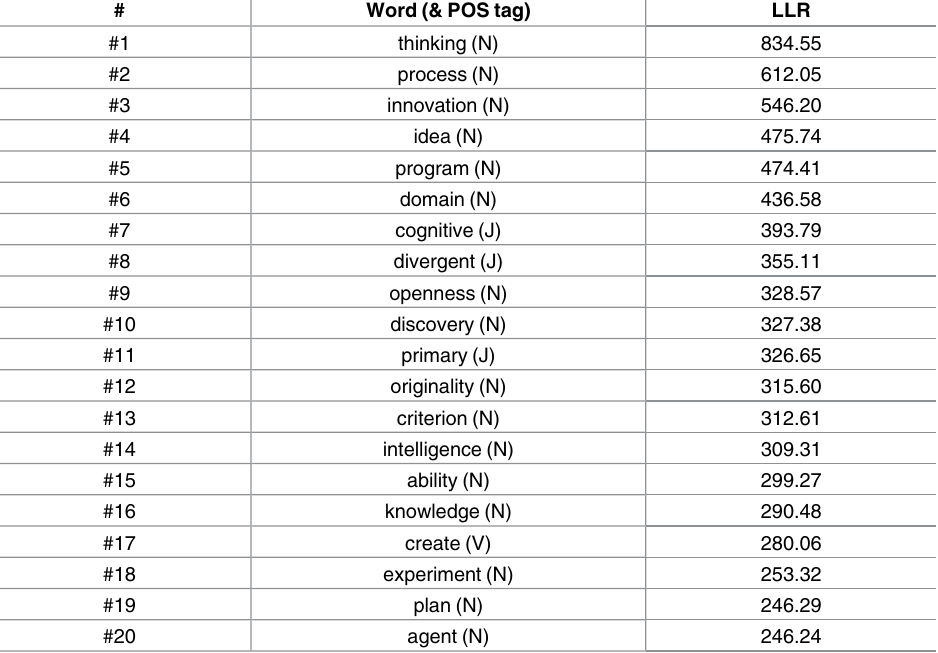
Table 1. The top 20 results (in descending order) of the log-likelihood ratio (LLR) calculations. A sig- nificant LLR score at p = 0.001 is 10.83. N.B. POS = Part Of Speech: N = noun, J = adjective, V = verb, R =